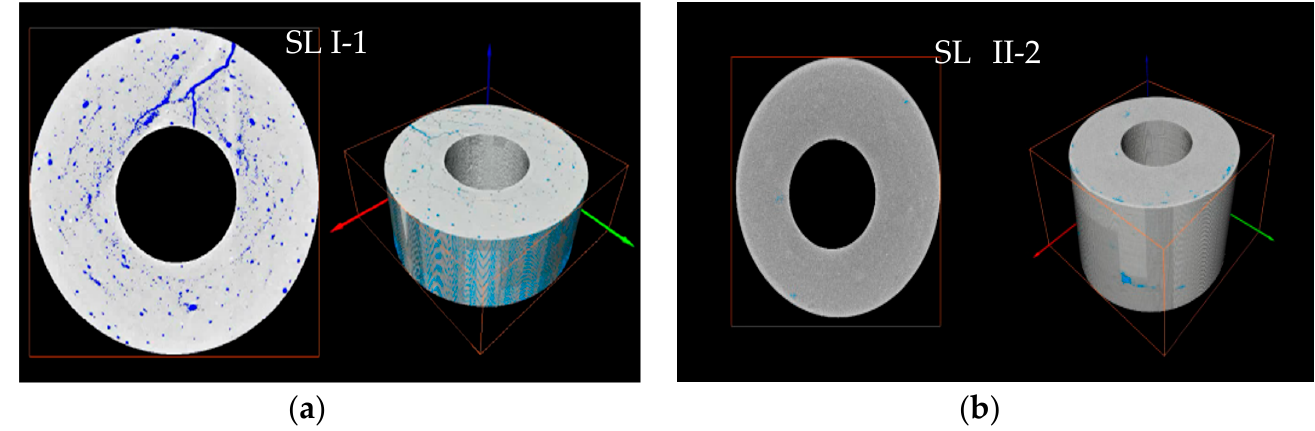
Figure 7. Interface characteristics of the cement sheath by CT scanning: ( a ) SL I-1; ( b ) SL II-2. 3.